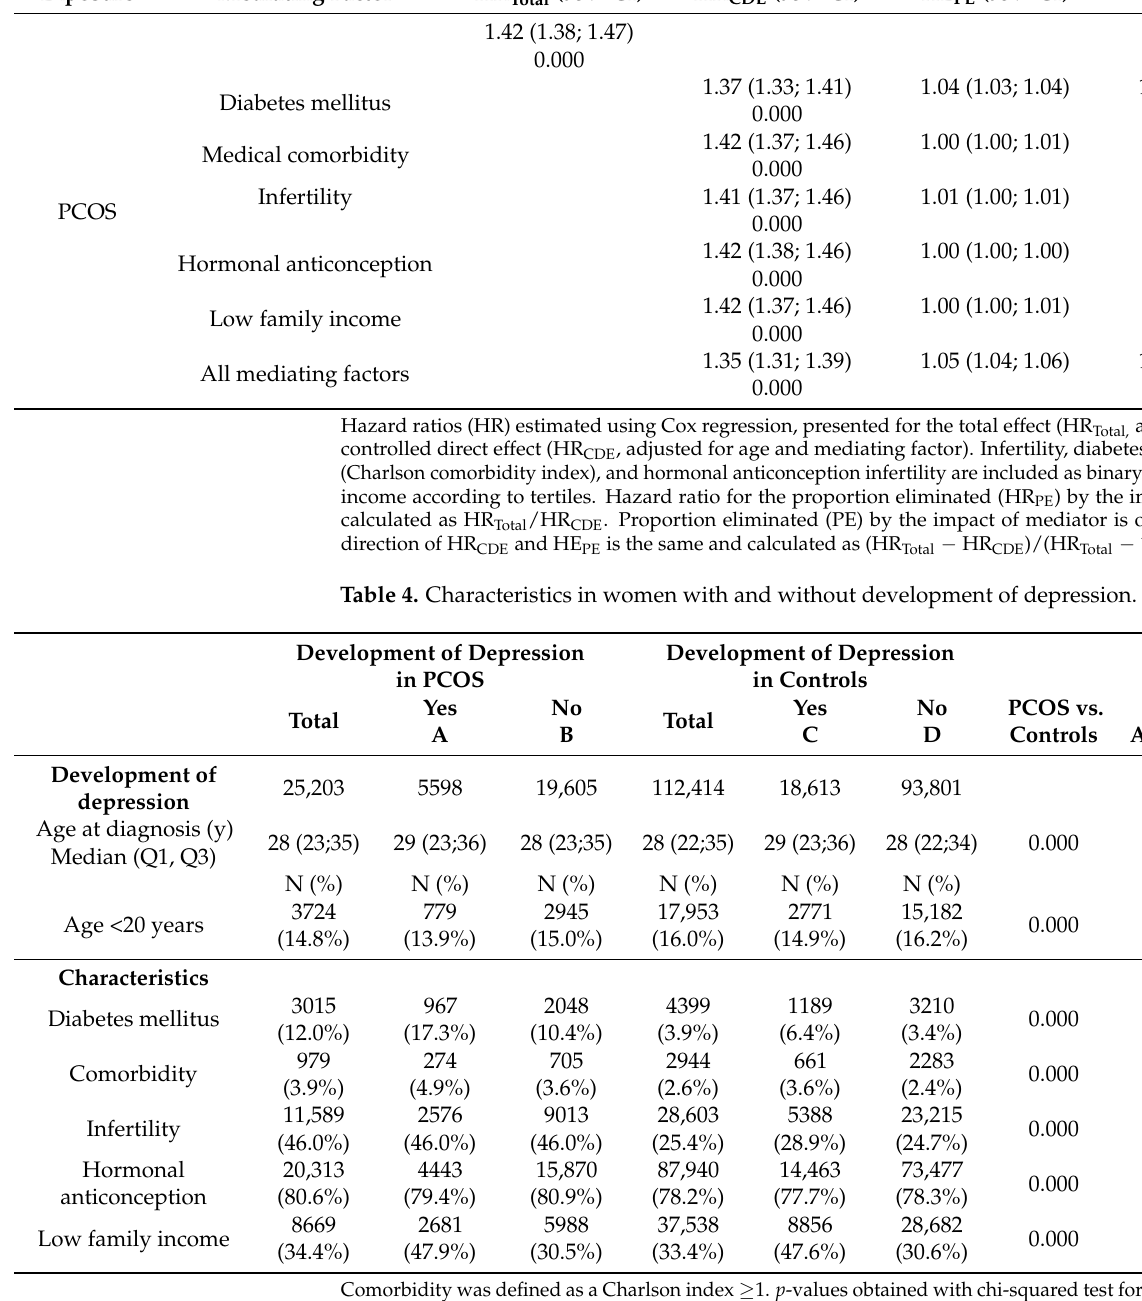
predictors of depression in PCOS OUH with estimates close to one (Table